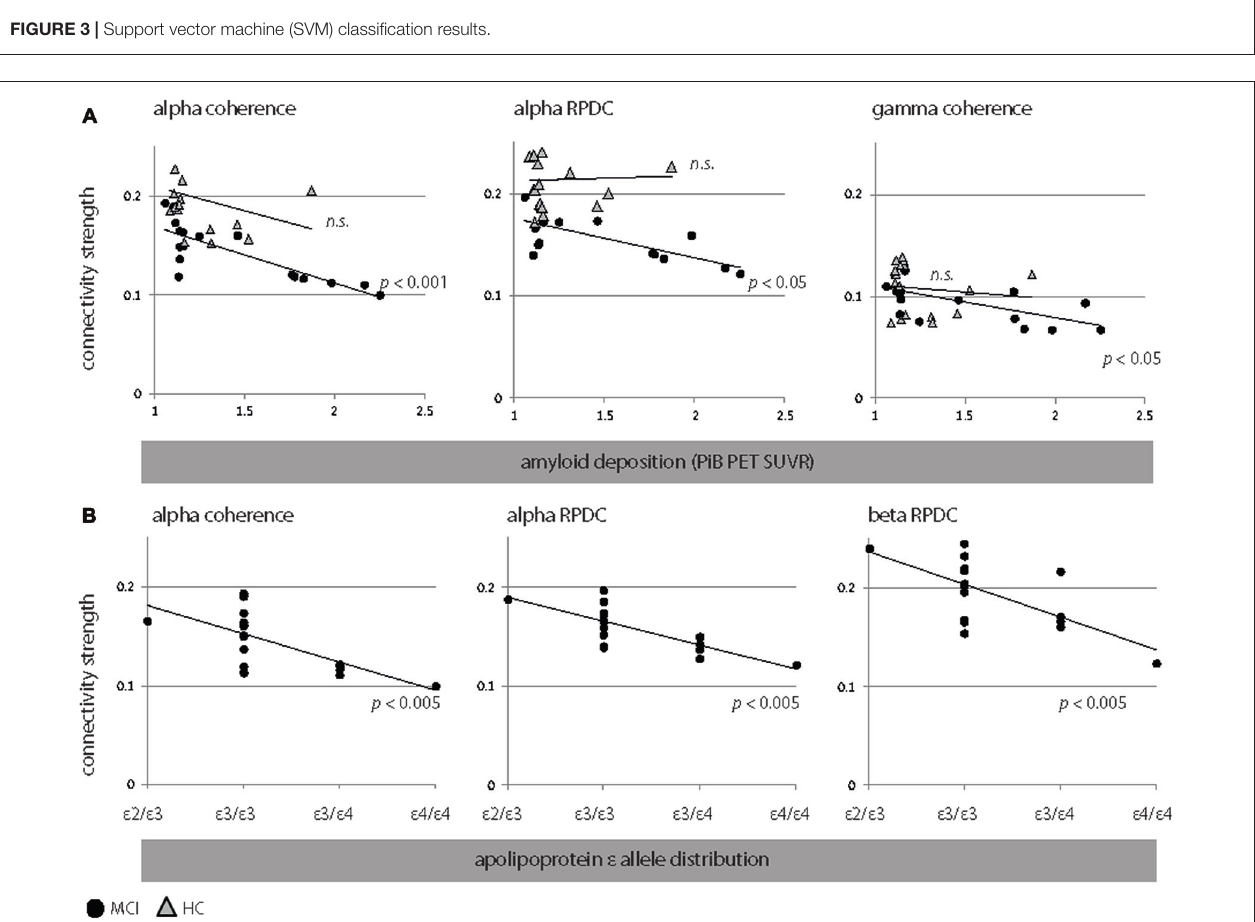
FIGURE 4 | Significant associations between EEG connectivity measures (coherence and RPDC) and clinical parameters. (A) Interactions between EEG connectivity measures and amyloid deposition. We show results for HC (triangles) and MCI (filled circles). (B) Interactions between EEG connectivity measures and apolipoprotein allele (ApoE) occurrence (sorted by an increasing genetic risk for developing Alzheimer’s disease (AD): ε 2/ ε 3, ε 3/ ε 3, ε 3/ ε 4, and ε 4/ ε 4) in MCI. Due to the non-normal distribution of amyloid beta (A β ; p < 0.001, Kolmogorov-Smirnov test), and the ordinal character of ApoE (MCI: ε 2/ ε 3, ε 3/ ε 3, ε 3/ ε 4, ε 4/ ε 4), we applied nonparametric Spearman’s rank order correlation analysis. However, we did not perform this analysis for ApoE in HC, as ApoE was dichotomous ( ε 3/ ε 3, ε 3/ ε 4). RPDC, renormalized partial directed coherence; SUVR, standard uptake value ratio .